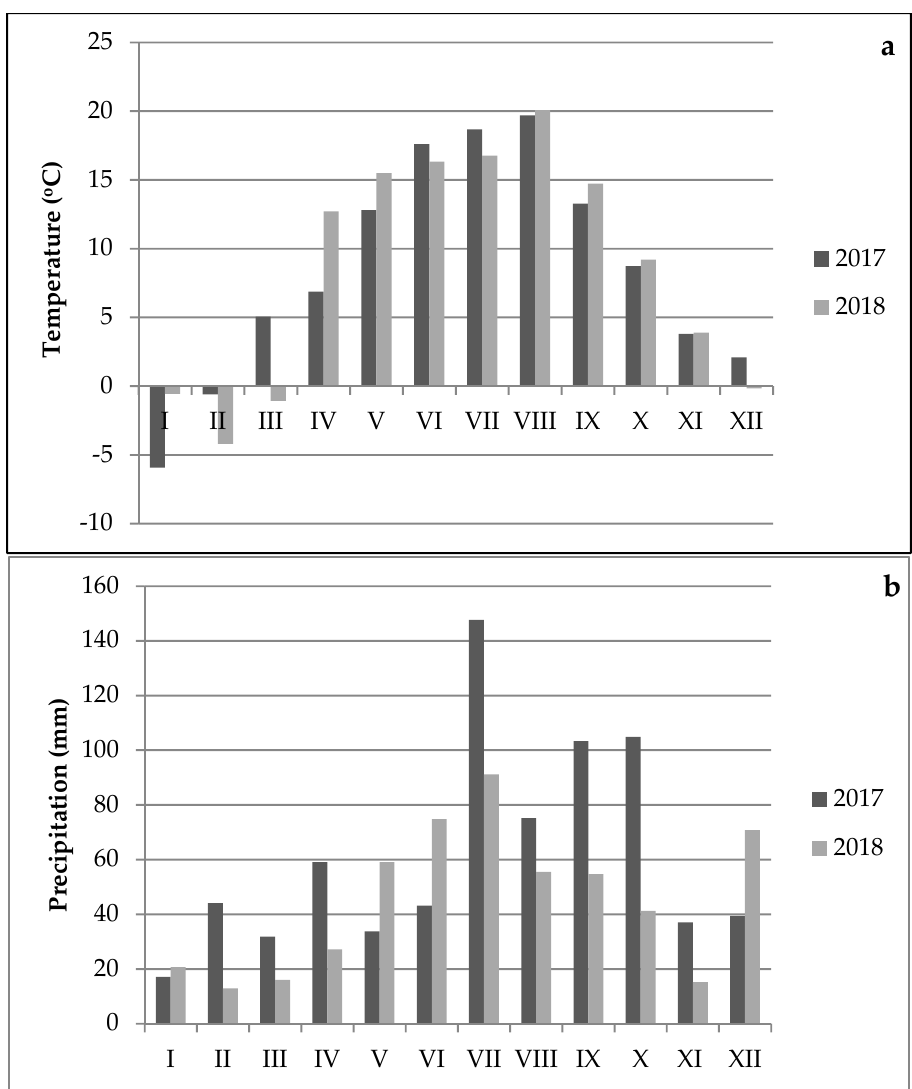
Figure 1. Weather data in the experimental field ( a ) Temperature; ( b ) Precipitation.